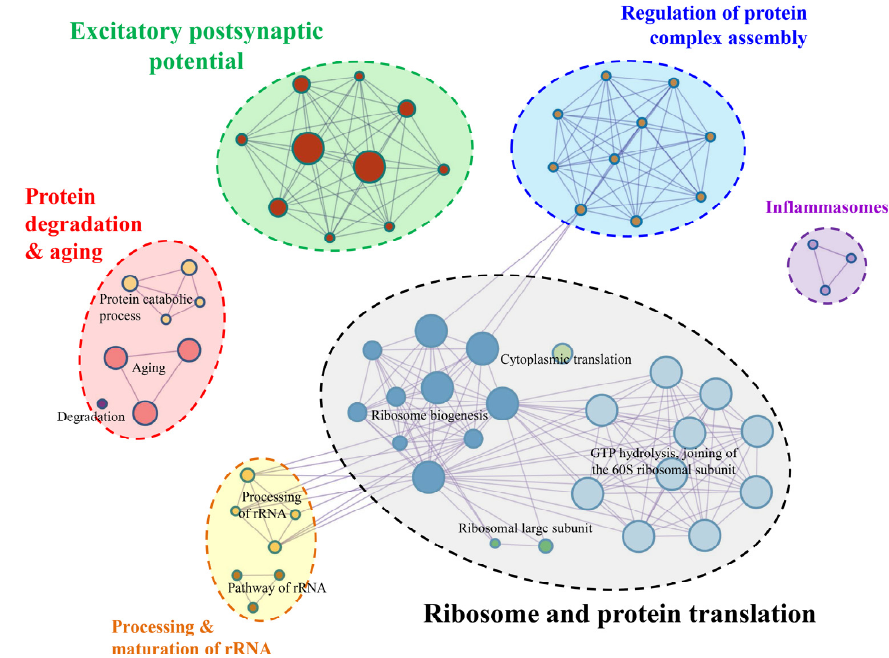
Figure 3. Function enrichment of all top 50 genes in six SGLs.